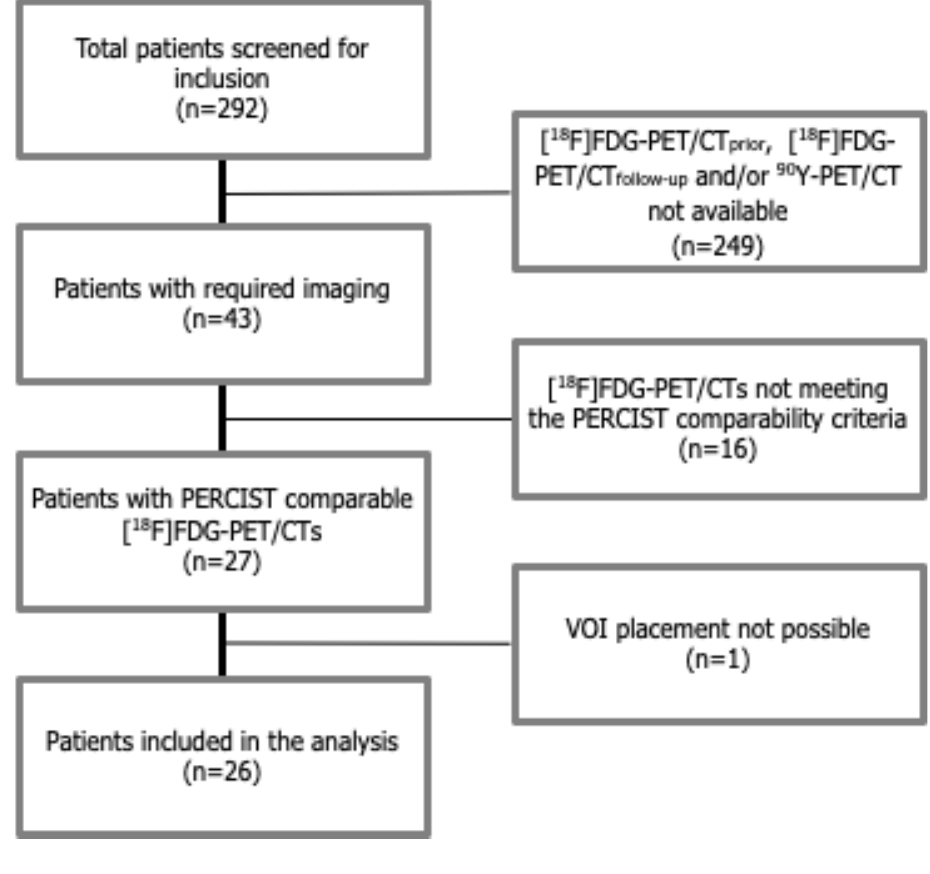
Figure 1. Flowchart of the study. The median post-injection times were 64.5 min, 62.3 min, and 65 min at [ 18 F]FDG- PET/CT prior and the 1 and 3 month [ 18 F]FDG-PET/CT follow-up scans, respectively (Table 2). The median absorbed dose per VOI was 31.3 Gy (range = 0.1 – 82.3 Gy). Overall, the median SUL VOI,liver at baseline was 1.8 (range = 1.2 – 2.8). A significant increase in SUL VOI,liver over time was found; the mean change in SUL VOI,liver per month increase in time was 0.05 (95%CI 0.02 – 0.09) at p = 0.00088 (Figure 2)(Table 3). The mean percent change in ΔSUL VOI,liver for every Gy increase in dose was − 0.04 (95%CI -0.22 – 0.14) at p = 0.67. At the patient level, the median SUL VOI (average of all VOIs of the liver parenchyma) was 1.8 (range = 1.5 – 2.3). The mean change in SUL VOI per month increase in time was 0.05 (95%CI 0.01-0.08); p = 0.016 (Table 3). Table 2. F-18 FDG-PET/CT specifications and measurements of the study population. Time After RE